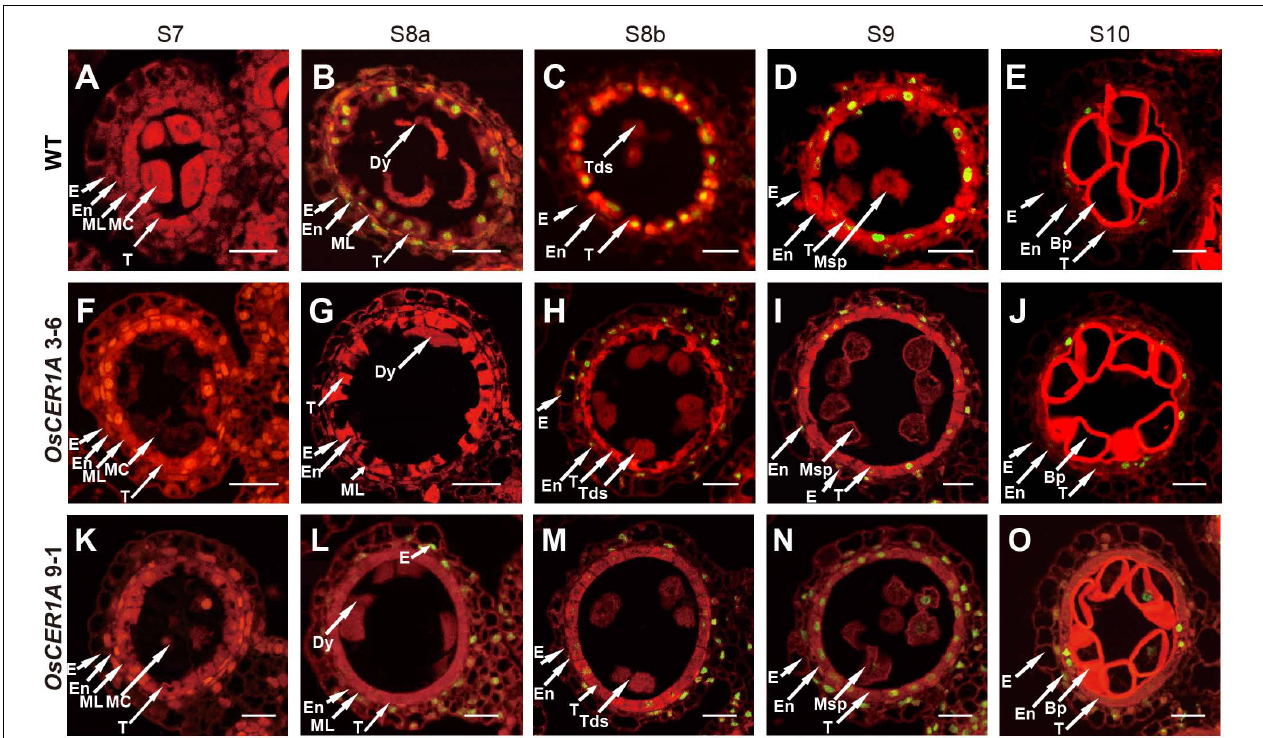
FIGURE 6 | Programmed cell death (PCD) defects in the tapetal cells of the OsCER1A lines. (A–E) TUNEL assay of the WT anthers at stage 7 (S7) (A) , stage 8a (S8a) (B) , stage 8b (S8b) (C) , stage 9 (S9) (D) , and stage 10 (S10) (E) . (F–J) TUNEL assay of the OsCER1A 3-6 anthers at S7 (F) , S8a (G) , S8b (H) , S9 (I) , and S10 (J) . (K–O) TUNEL assay of the OsCER1A 9-1 anthers at S7 (K) , S8a (L) , S8b (M) , S9 (N) , and S10 (O) . The red fluorescence showed tissues stained with propidium iodide and the yellow fluorescence showed TUNEL-positive nuclei. Bp, bicellular pollen; Dy, dyad cell; E, epidermis; En, endothecium; MC, meiotic cell; ML, middle layer; Msp, microspore; Tds, tetrads; T, tapetum. Bars = 50 µ